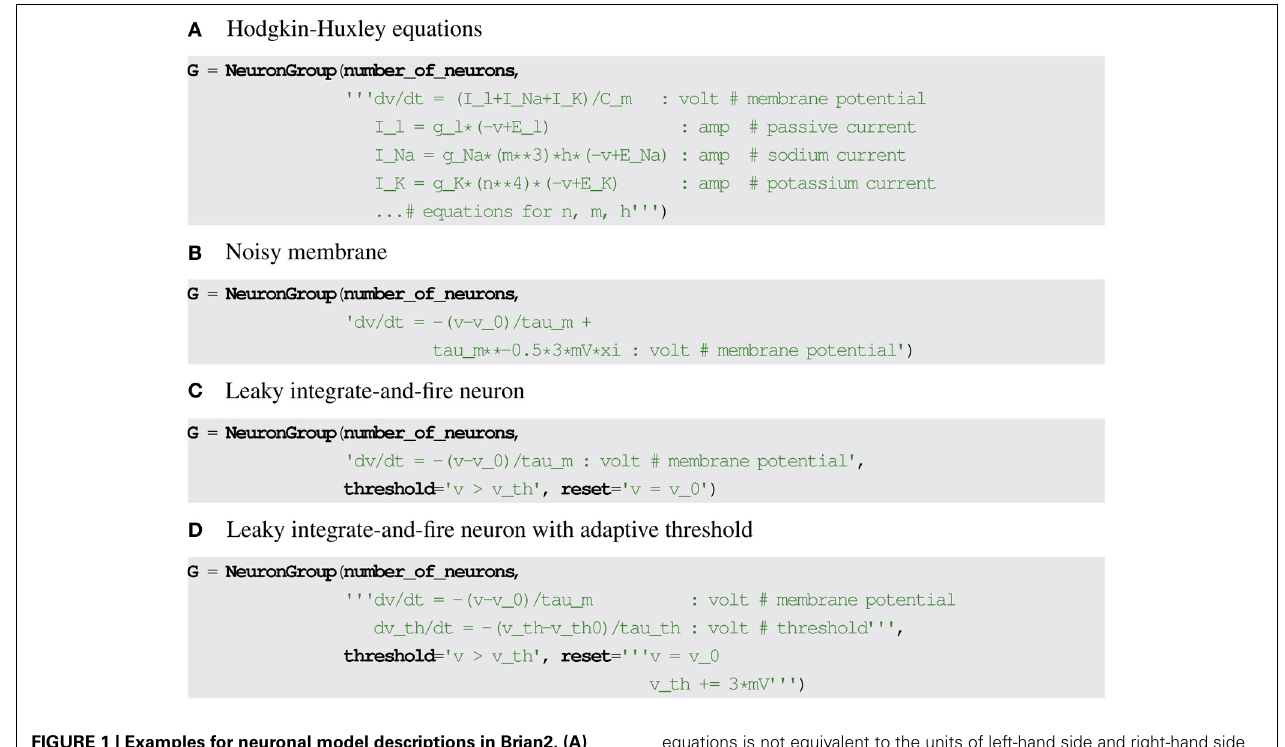
equations is not equivalent to the units of left-hand side and right-hand side of the equations ( volt vs. volt/second ). (B) The symbol xi is used to refer to a stochastic variable for defining stochastic equations. (C,D) Threshold conditions and reset statements are also defined by